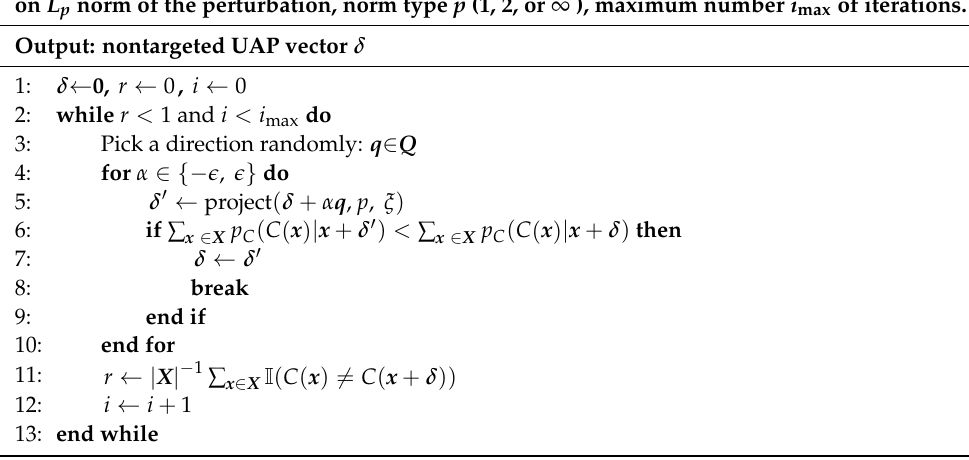
Algorithm 1 Computation of a nontargeted